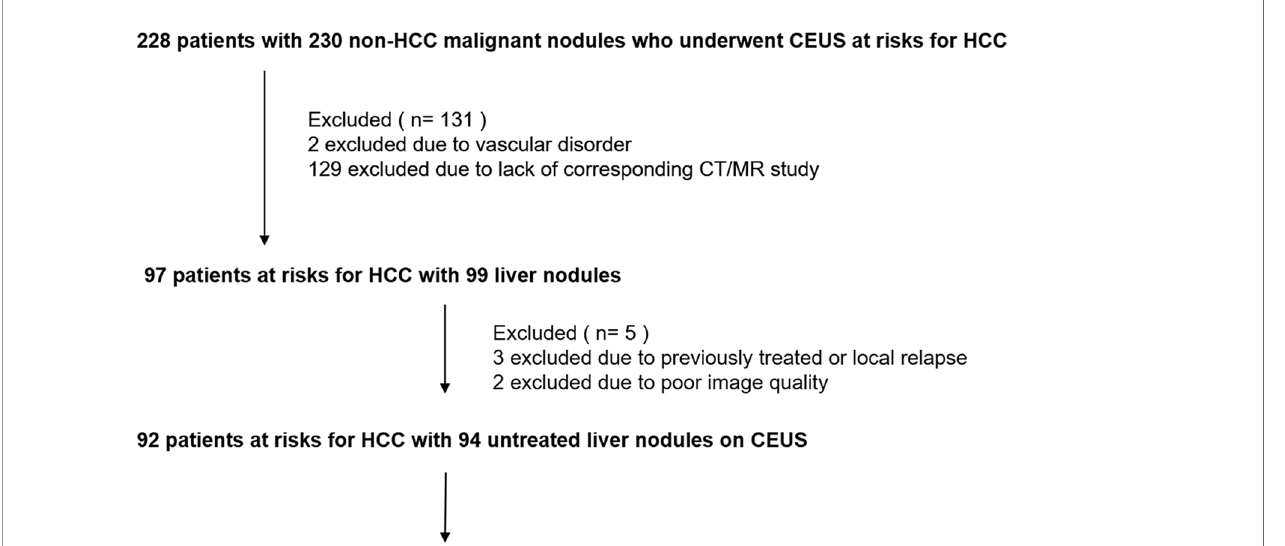
FIGURE 1 | Flowchart of study sample.CEUS, contrast enhanced ultrasound; HCC, hepatocellular carcinoma; LI-RADS, Liver Imaging Reporting and Data